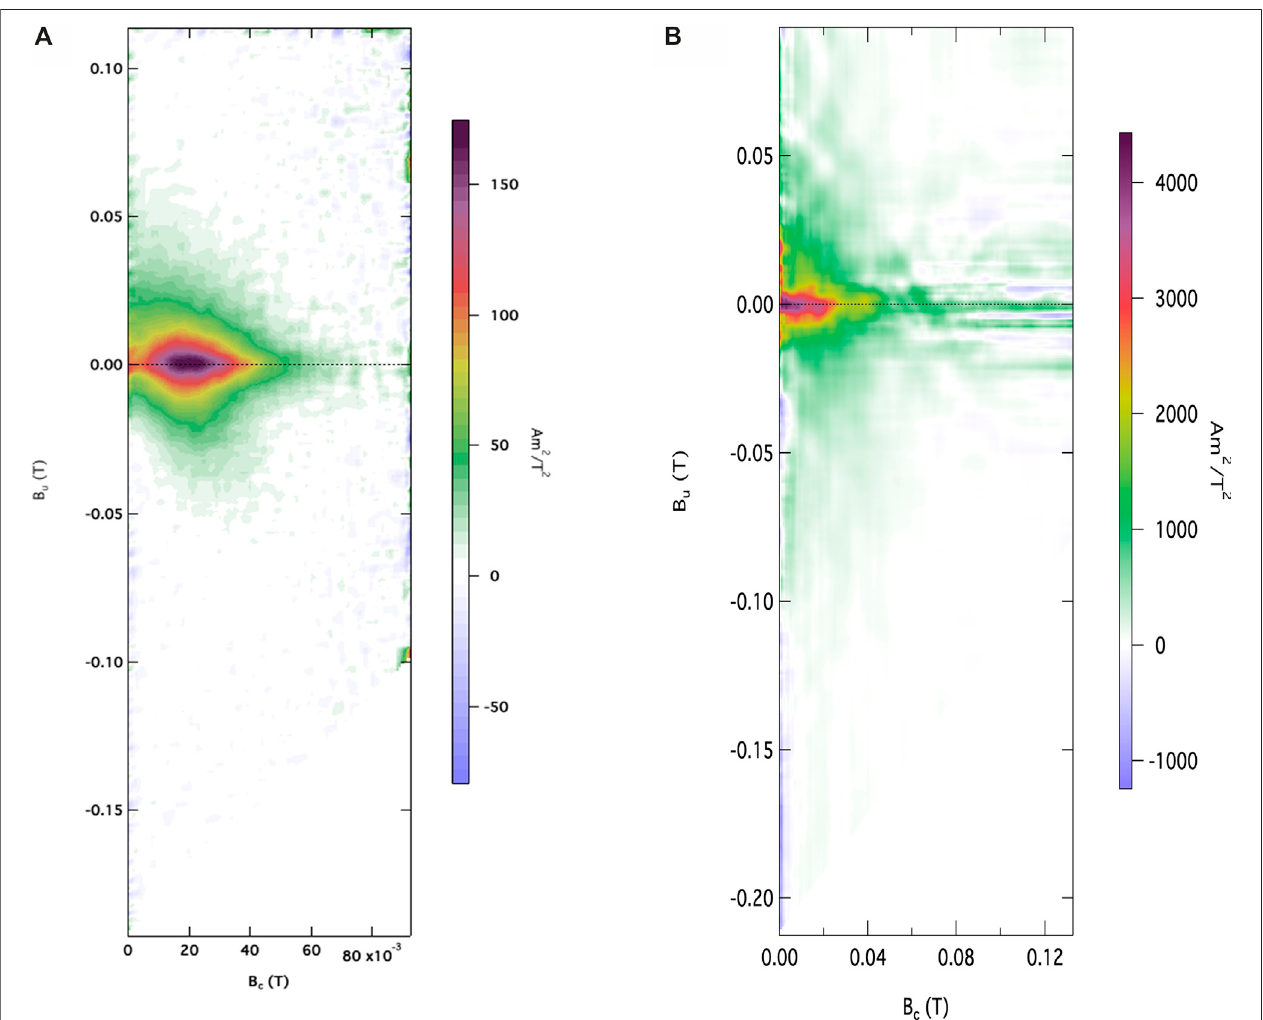
FIGURE 3 | FORC distribution of sample collected at (A) 2.5 m (anthropogenic deposit sediments) and (B) 6.0 m (Quaternary sediments). At 2.5 m the contours present small asymmetrical spread in the Bu axis, with a peak around zero, indicating single domain behavior with little to no magnetic interaction. The coercivity distributionpeak in Bc around 20 mT isevidence ofmagnetite. At6.0 m, open contours divergingasymmetricallyon the Bu axis indicate dominance ofSPpopulation of grains.